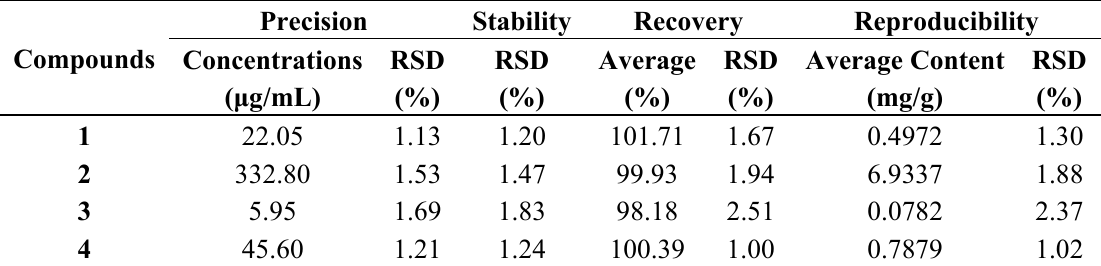
Table 3. Precision, stability, recovery and reproducibility of the assay method. Precision Stability Recovery Reproducibility Compounds